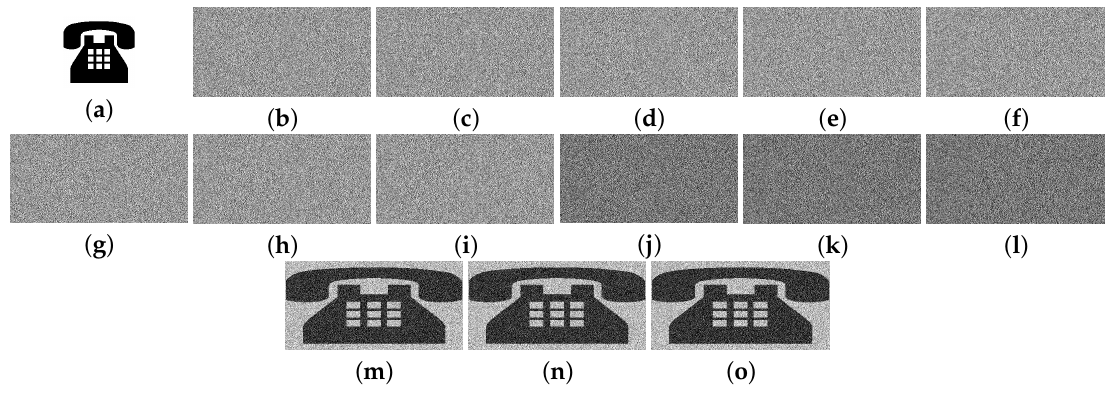
Figure 2. The shadow images and reconstructed images for (4, 5)-XVC scheme: ( a ) secret image,